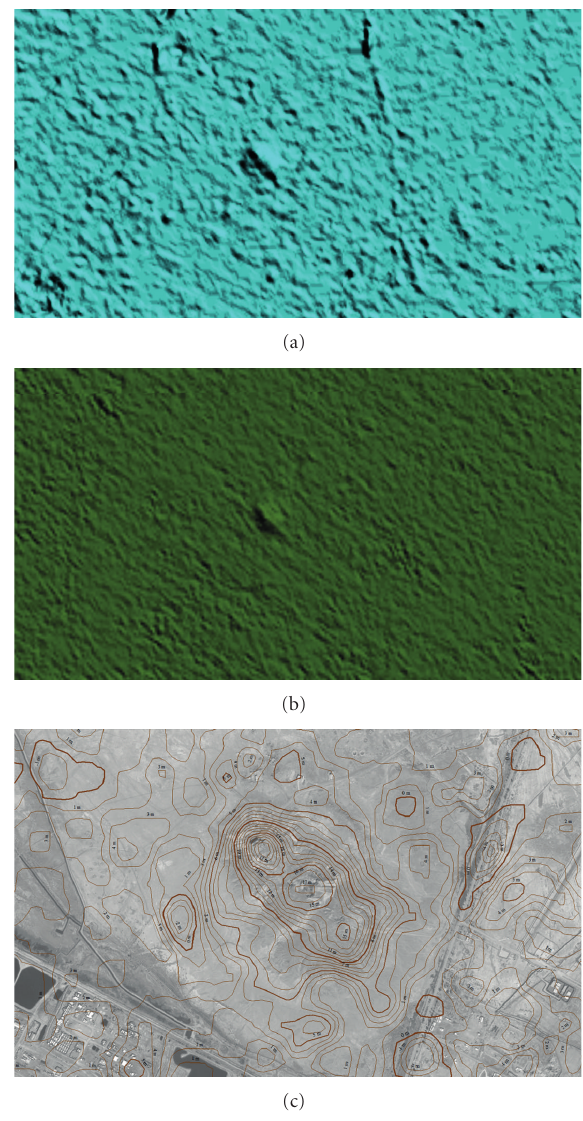
Figure 5: The hill of Ur in ASTER (a) and SRTM (b) DEMs; contour lines (c) extracted from the SRTM DEM, draped with the QuickBird-2 panchromatic image of